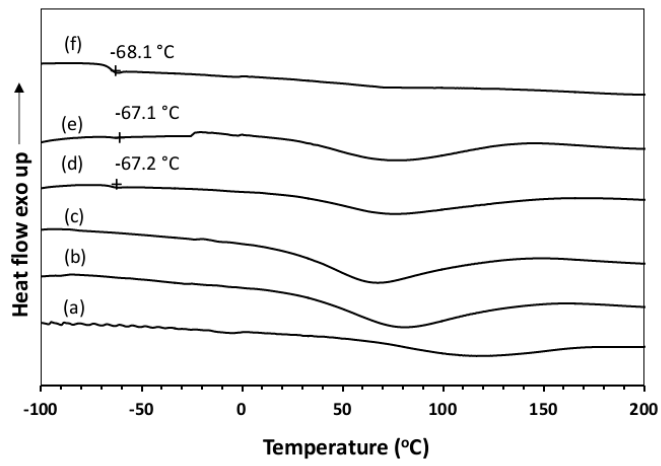
Figure 8. Differential scanning calorimetry (DSC) chromatograms of BC ( a ), NR ( f ), and NR–BC films of 0.5 NR–BC50 ( b ), 2.5 NR–BC50 ( c ), 5.0 NR–BC50 ( d ), and 10.0 NR–BC50 ( e ).